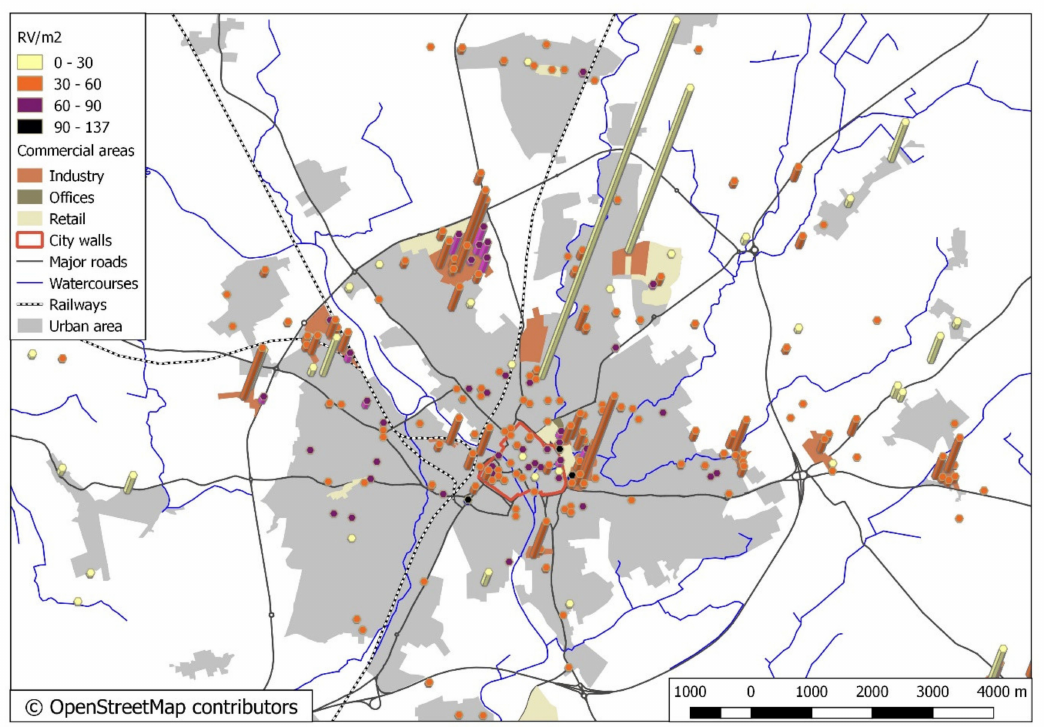
Figure 5. Industrial RV / m 2 (2019 values) aggregated within a 100m grid; extruded to indicate total